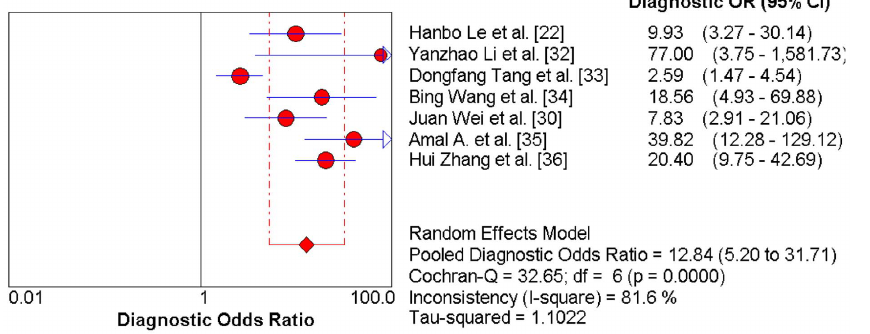
Figure 5. Diagnostic Odds Ratio with Cochran-Q value.